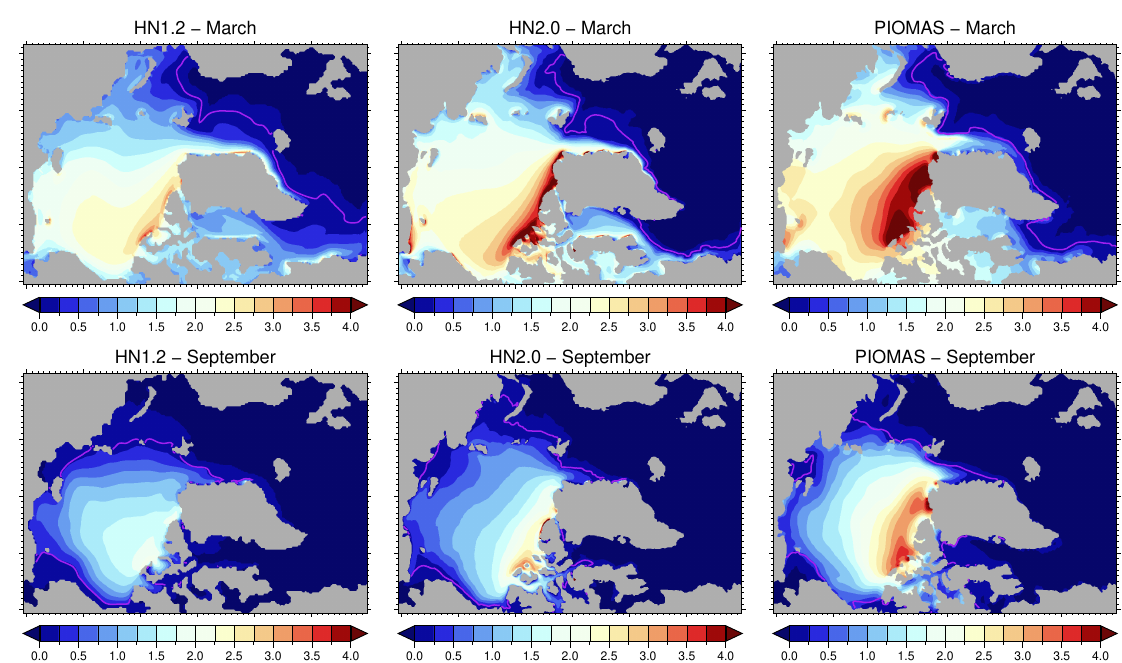
Figure 4. Sea-ice thickness climatology (in meters) for March ( top ) and September ( bottom ) from ERAI-driven ensemble simulations with HN1.2 ( left ), ERAI-driven ensemble simulations with HN2.0 ( middle ), and PIOMAS data ( right ). PIOMAS data were interpolated to the T-grid of HN2.0. The purple lines represent the climatological 15% sea-ice concentration contour of the respective dataset. Land areas of the T-grid are shown in gray. Note that the T-grids of HN1.2 and HN2.0 slightly differ due to the different horizontal resolution. All data refer to the period